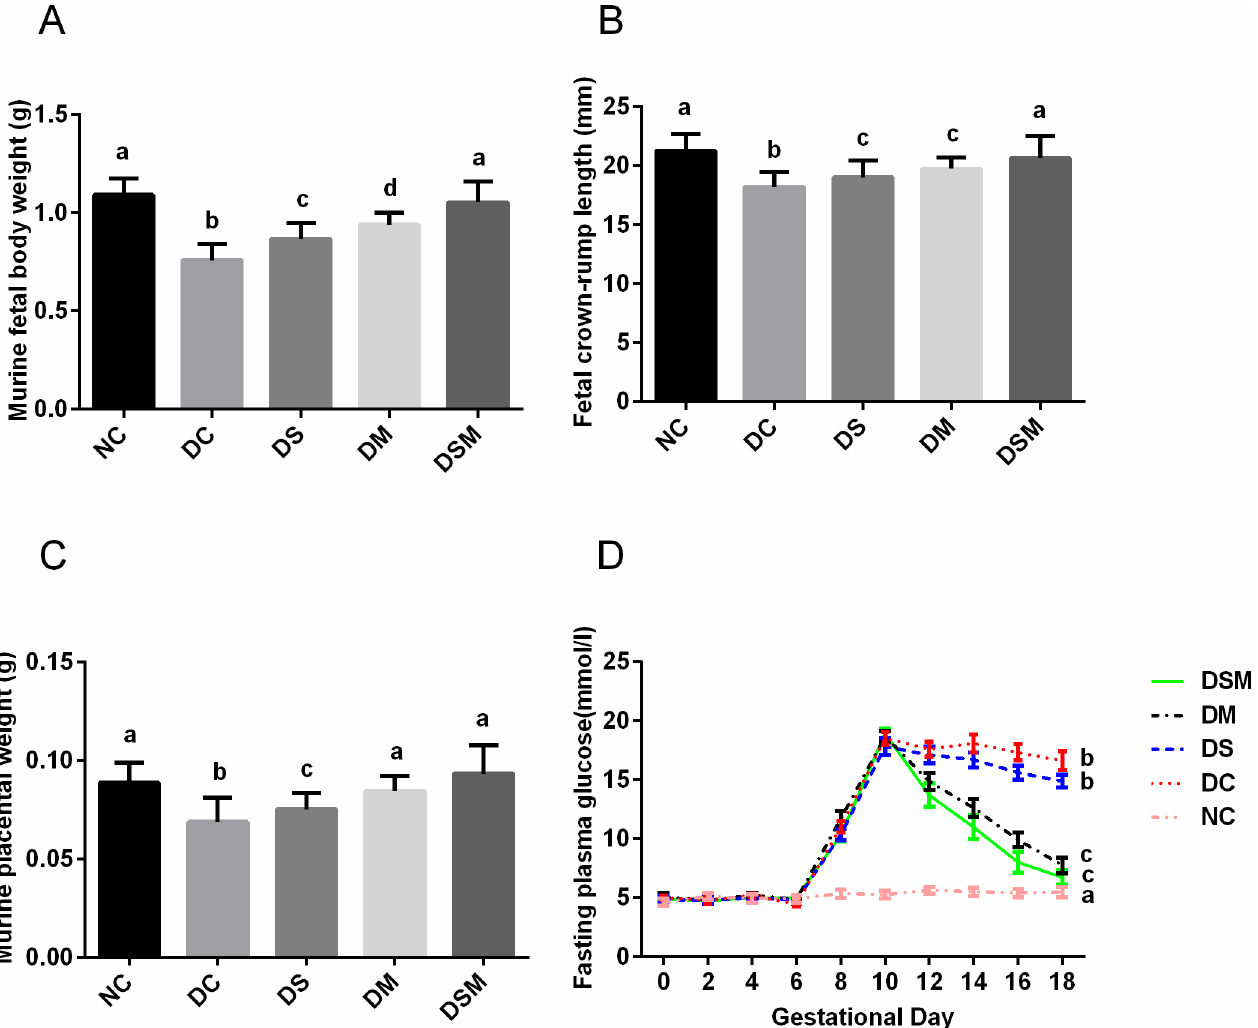
Fig 1. Combined intervention by swimming plus metformin most effectively normalized fetal growth restriction and hyperglycemia caused by GDM. (A) Fetal body weights in different groups with/without interventions. (B) Fetal crown-rump lengths in different groups with/without interventions. (C) Placental weights in different groups with/without interventions. (D) Maternal glucose concentrations from GD0 to GD18 in different groups with/without interventions. The blood glucose values among different groups in this study are compared in GD18. The values represent the mean ± SEM, n = 10/group. The columns with different letter (a, b, c, d) are significantly different, P < 0.05 (ANOVA, SNK). NC: normal control group, DC: GDM control group, DS: GDM treated with swimming group, DM: GDM treated with metformin group, DSM: GDM treated with swimming plus metformin